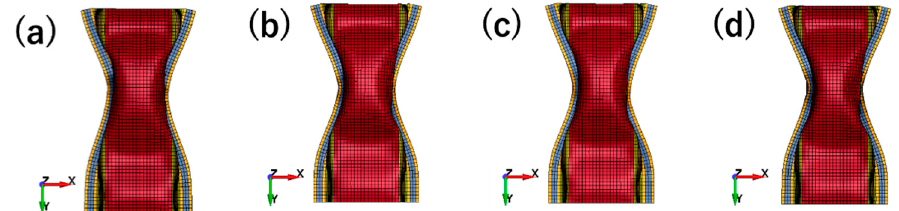
Figure 13. Deformation modes under different wall thickness: ( a ) 2.00 mm; ( b ) 1.96 mm; ( c ) 1.90 mm; ( d ) 1.80 mm.